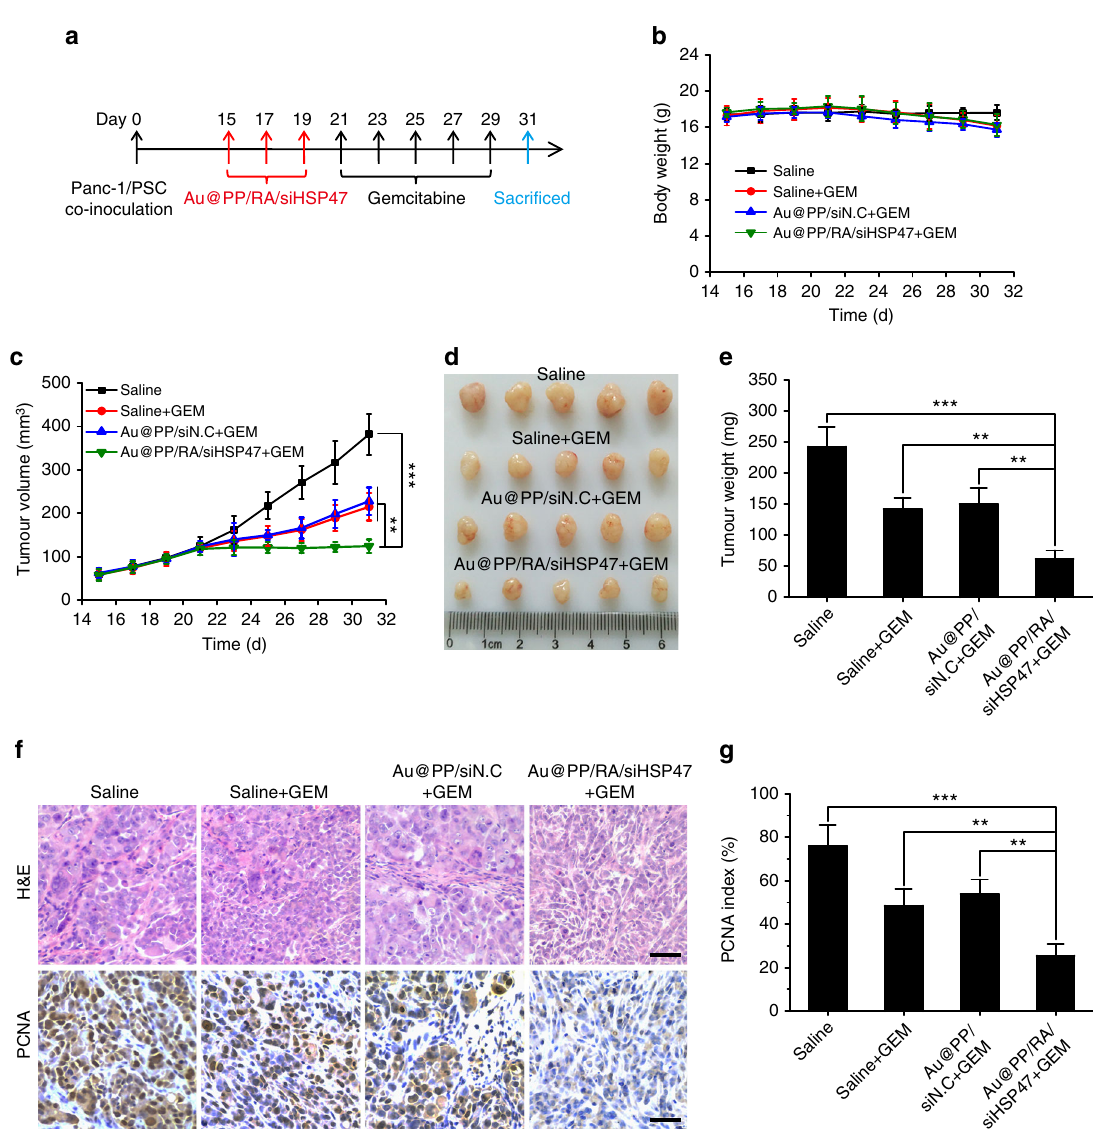
Fig. 8 Combined treatment of Panc-1/PSC subcutaneous xenografts. a Scheme of combination therapy. The pancreatic tumour-bearing mice received Au@PP/RA/siHSP47 intravenously every 2 days for three injections and subsequently received gemcitabine intravenously every 2 days for fi ve injections. b Body weight changes of mice during treatment. The data are shown as the mean ± s.d. ( n = 5). c Tumour growth curves during treatment. The data are shown as the mean ± s.d. ( n = 5). The mean tumour volumes were analysed using the Mann – Whitney U test. ** p < 0.01, *** p < 0.001. d Image of excised tumours. e Tumour weights after treatment. The data are shown as the mean ± s.d. ( n = 5). ** p < 0.01, *** p < 0.001 (Student ’ s t test). f Histological studies with H&E and immunohistochemical staining of proliferating cell nuclear antigen (PCNA) in tumour sections. Scale bars, 50 μ m. g Quanti fi cation of PCNA- positive tumour cells. The data are shown as the mean ± s.d. ( n = 5). ** p < 0.01, *** p < 0.001 (Student ’ s t